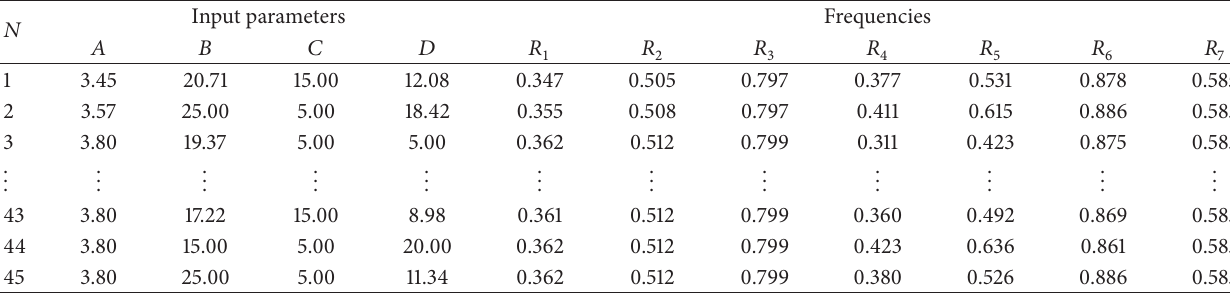
Table 6: Experimental samples.